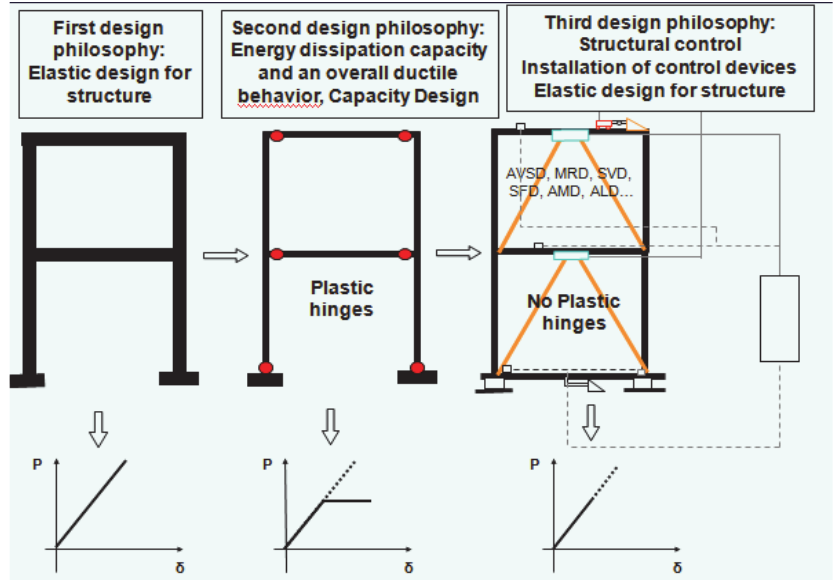
Figure 1 : The three design philosophies of design of